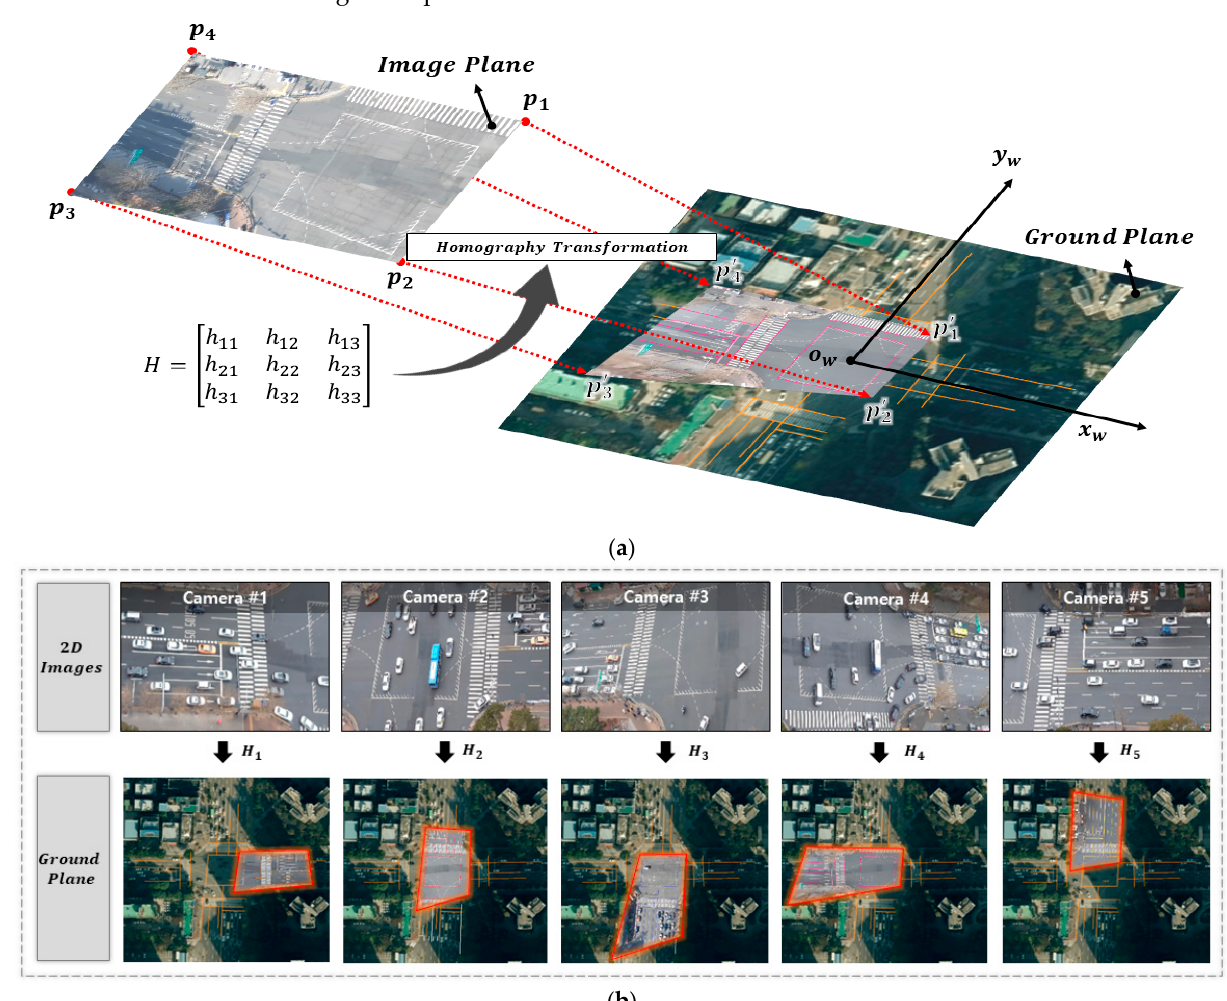
Figure 10. Image projection through homography matrix H ( a ); homography transformation between single-camera scenes and ground plane in this paper ( b ).